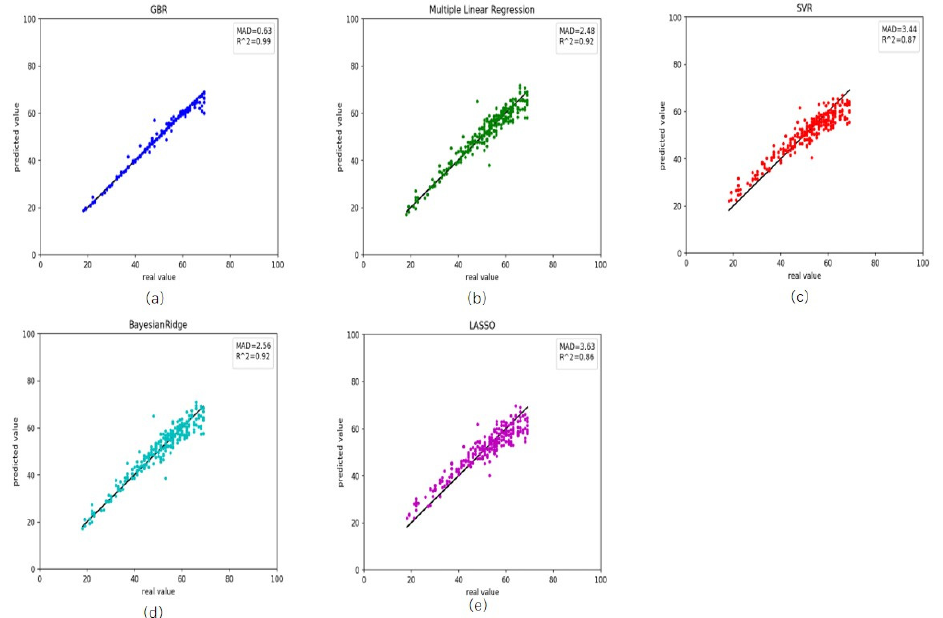
Figure 4. Comparison results between the actual age and predicted age by five different models on the training rheumatoid arthritis data. ( a ) gradient boosting regression, ( b ) multiple linear regression, ( c ) support vector regression, ( d ) Bayesian ridge regression and ( e ) lasso regression.